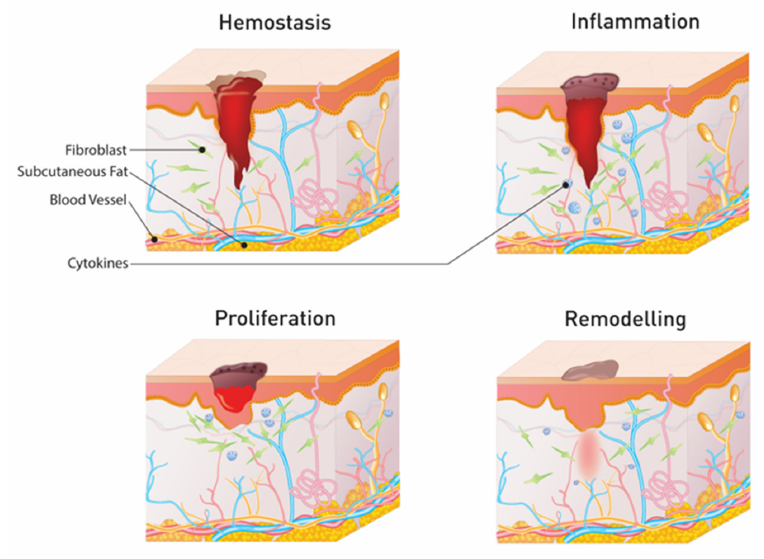
Figure 2. Stages of wound healing of skin.